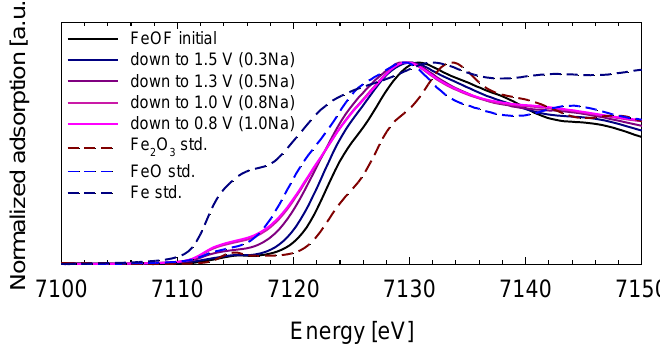
Figure 2. Fe K-edge X-ray absorption near edge structure (XANES) spectra of initial and cycled FeOF cathode pellets discharged to 1.5, 1.3, 1.0, and 0.8 V, respectively, along with reference samples of Fe 2 O 3 , FeO, and metallic Fe.